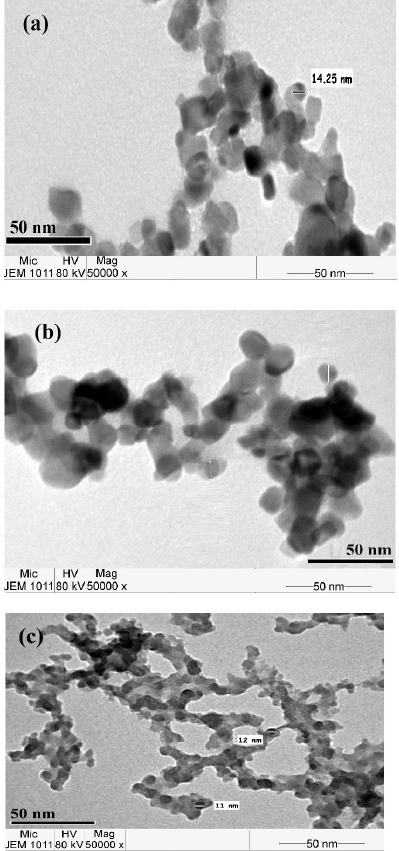
Figure 5. TEM micrographs of TiO 2 capped with ( a ) EOA, ( b ) ELOA and ( c ) ELNA.